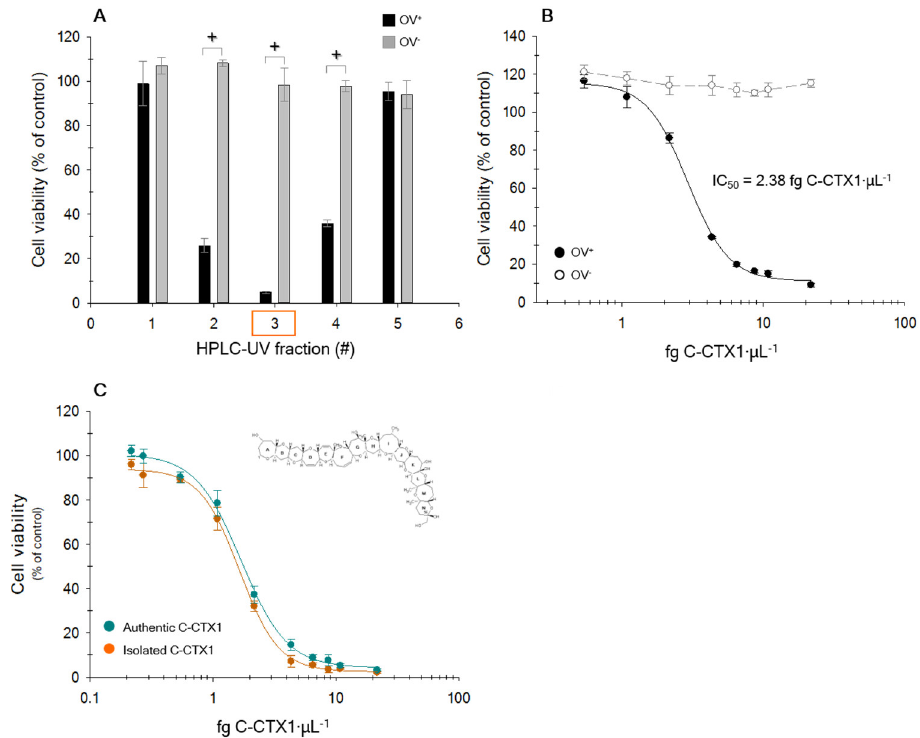
Figure 5. ( A ) N2a toxicity profile after the HPLC fractionation. C-CTX1 was collected individually in Fr. #3. + symbol: fractions showing CTX-like activity; ( B ) Toxic response of sensitized (●) and non- sensitized ( ○ ) cells obtained from the analysis of Fr. #3 by N2a-MTT assay and ( C ) comparative dose- response curve of authentic C-CTX1 and C-CTX1 isolated in this